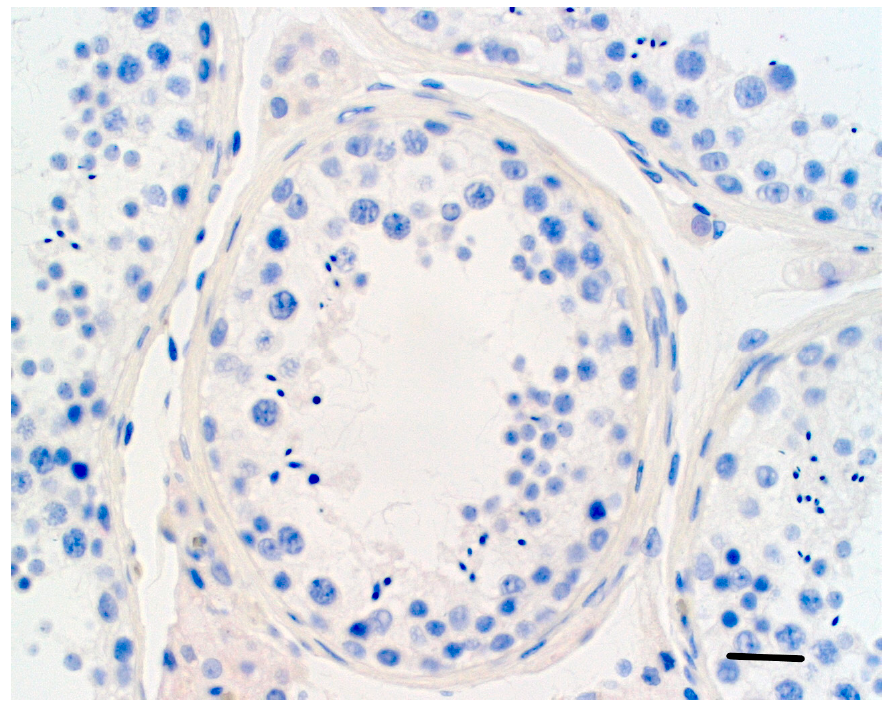
Figure 6. A control adult testis without PRDM9 antibodies, lacking red protein staining. (Horizontal bar; 30 µ).